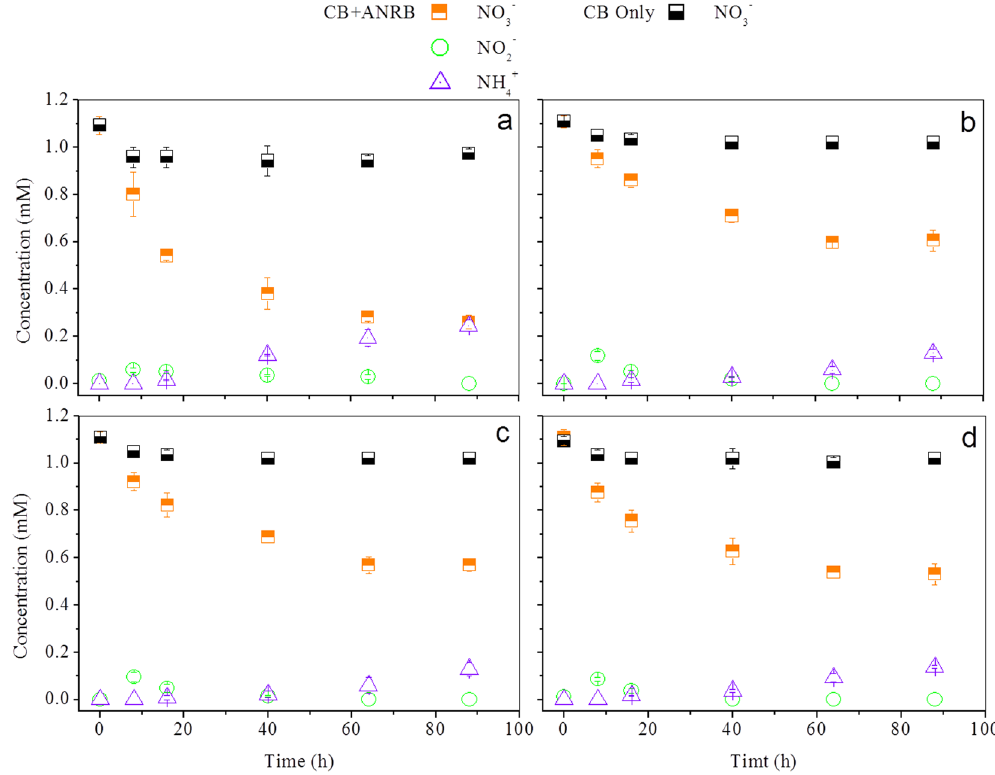
Figure 5. Nitrate reduction with charged CB electrode as electron donor. ( a ) electrodes unsintered were applied, ( b ) electrodes sintered under 100%N 2 were applied ( c ) electrodes sintered under 30%O 2 and 70%N 2 were applied, ( d ) electrodes sintered under 70%O 2 and 30%N 2 were applied (ANRB: autotrophic nitrate-reduction bacteria, each data was reported as average value from replicate CB electrodes and triple